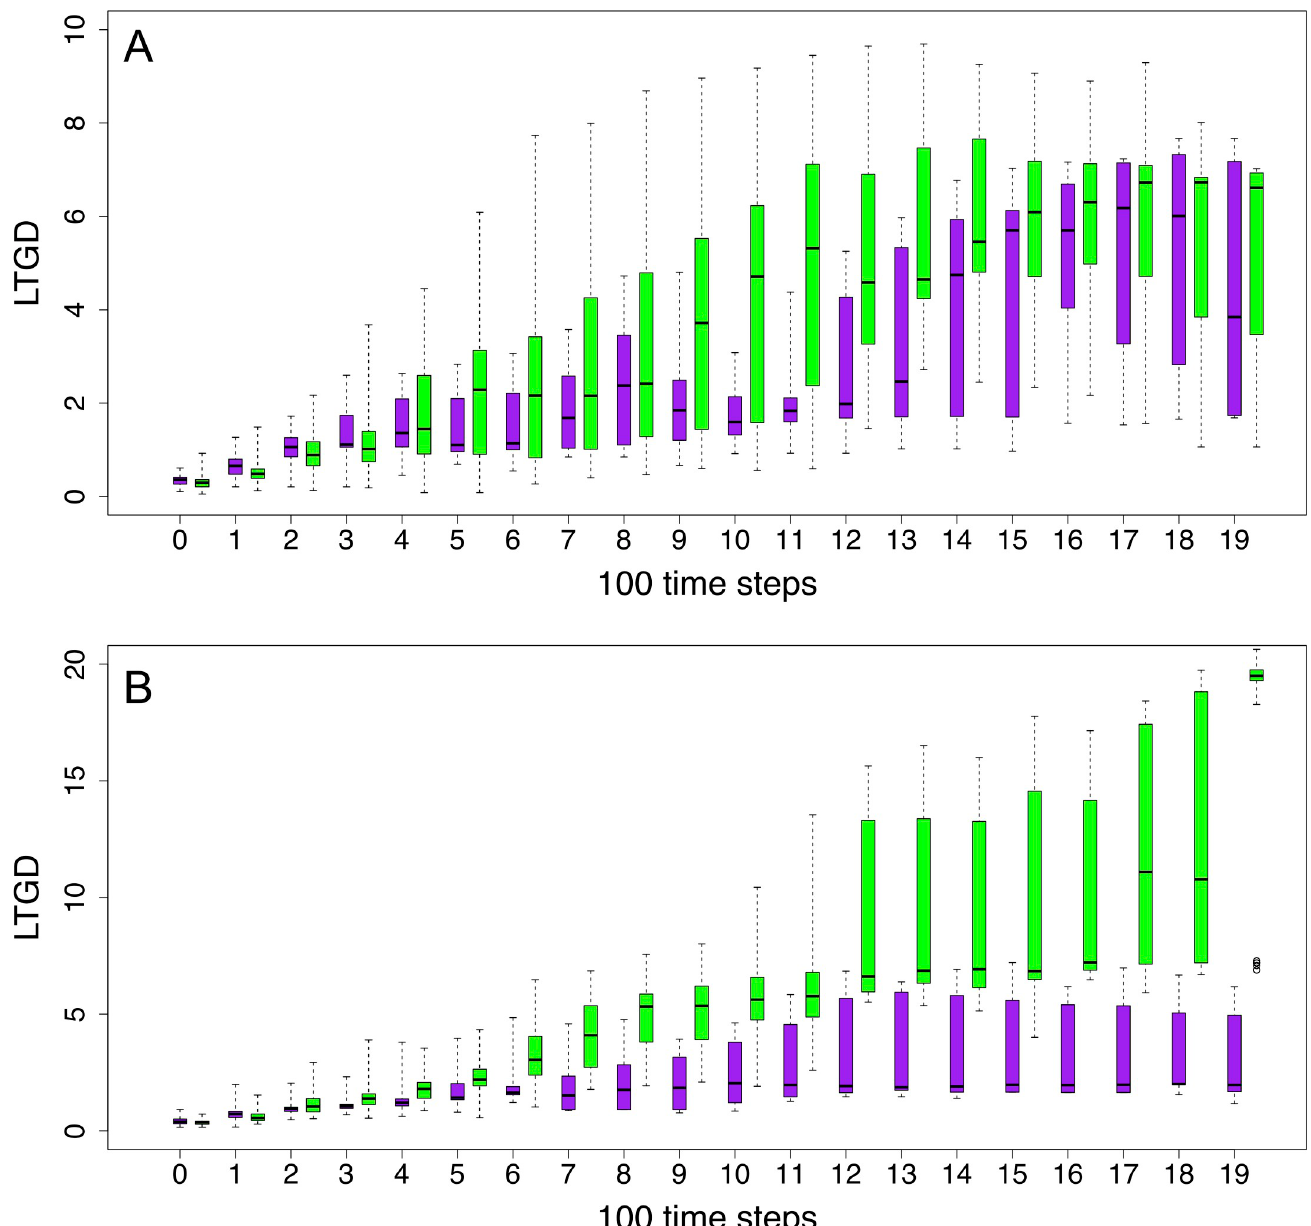
Fig 6. Evolution of the average LTGD of a subpopulation of DOs with stable and adapted GRNs versus all DOs from 40 experiments (simulations) under a dynamically changing environment (70% food reduction). Purple boxes represent the overall population and green boxes represent the population with stable GRNs (i.e. considered adapted). (A) polyploid populations; (B) non-polyploid populations. Interpretation is as in Fig 5.